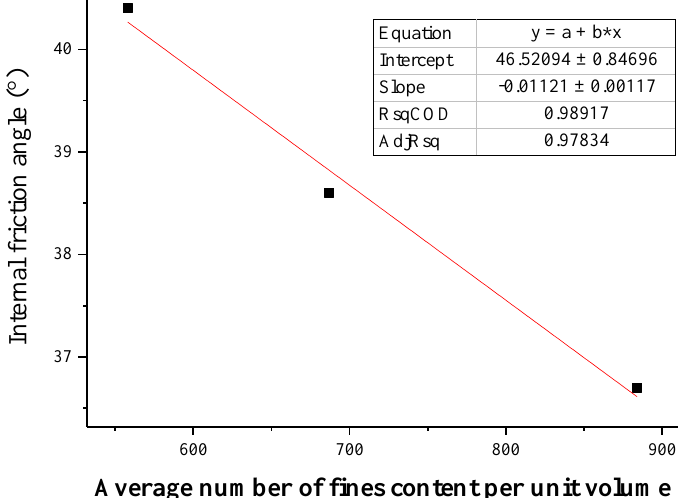
Figure 22. Fitting curve of the fine particle content and permeability coefficient per unit volume.